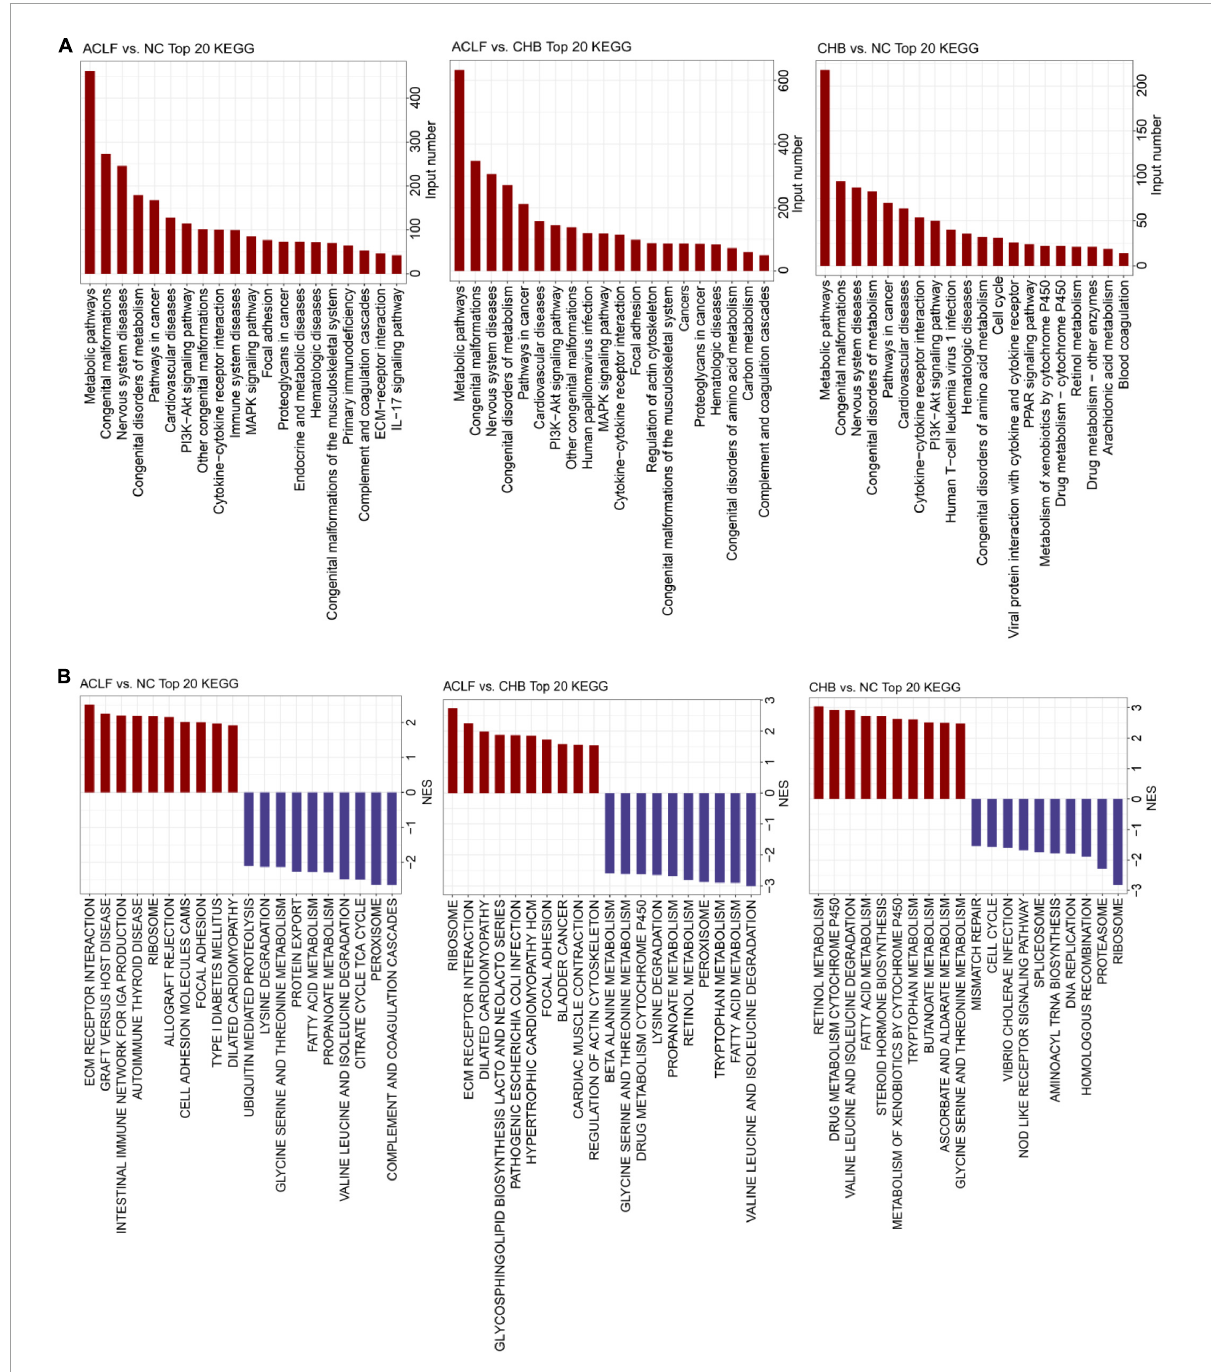
FIGURE2 Functional alterations during acute-on-chronic liver failure (ACLF) development. (A) Bar chart of KEGG pathway enrichment analysis of the DEGs showing the top 20 enriched KEGG pathways. (B) Twenty significantly upregulated and downregulated biological processes were identified using GSEA in pairwise comparisons among the three groups. KEGG, Kyoto Encyclopedia of Genes and Genomes; GSEA, gene set enrichment analysis.